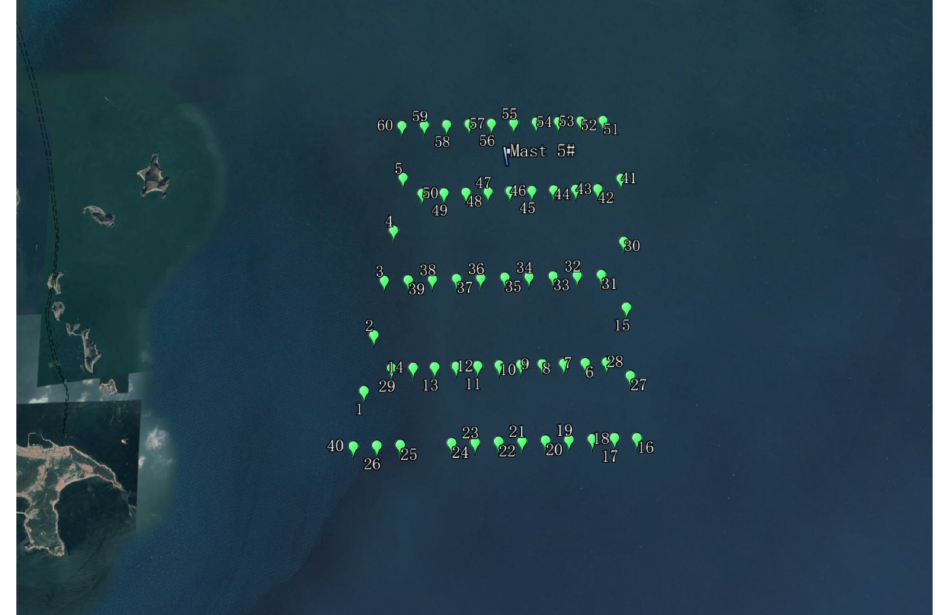
Figure 1. Schematic diagram for site layout of wind farm and position of met-mast.